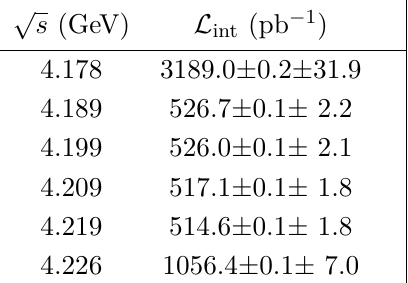
Table 1 . The integrated luminosities ( L int ) for various centre-of-mass energies. The first and second uncertainties are statistical and systematic,